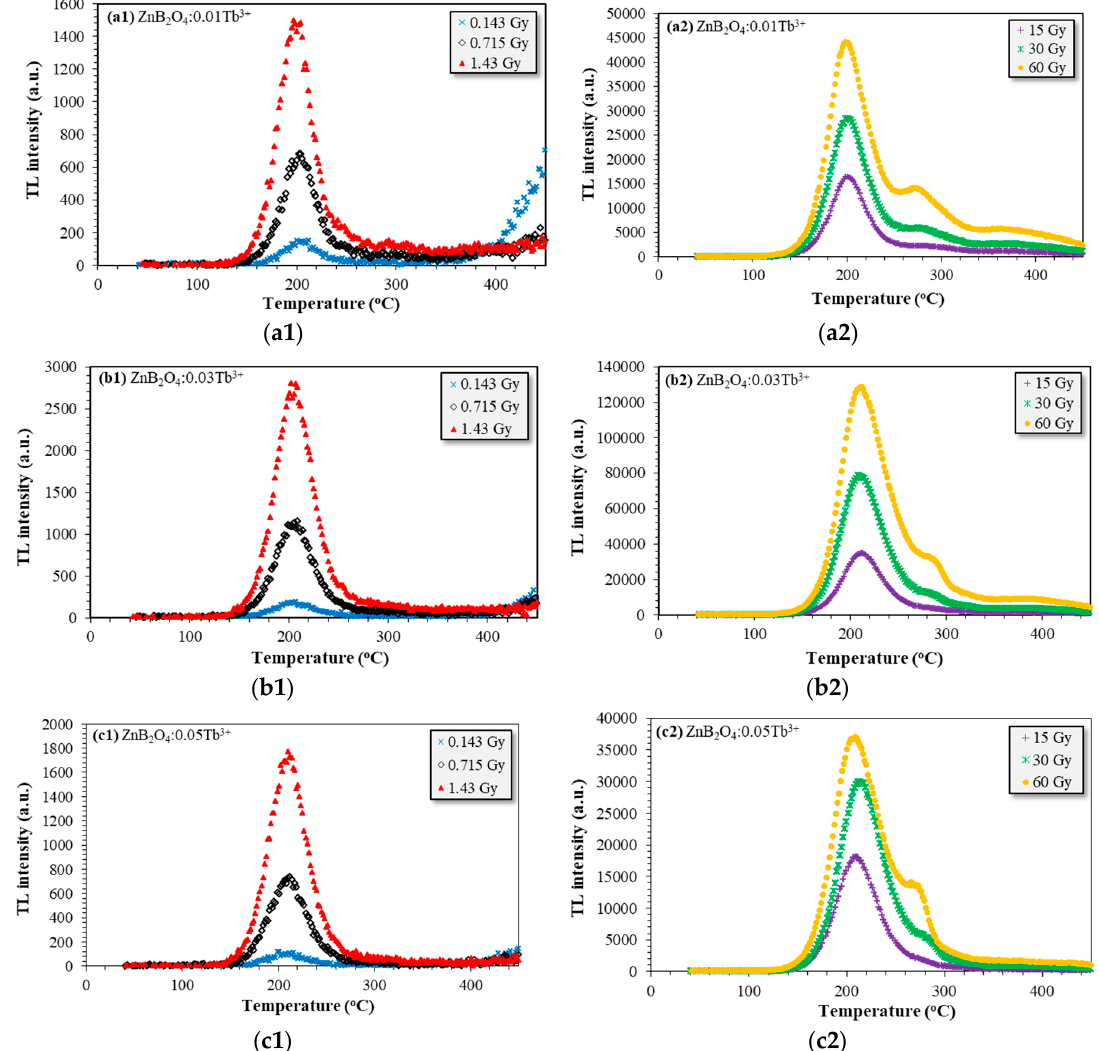
Figure 3. Experimental TL glow curves of ZnB 2 O 4 :xTb 3 + ( a1–a2 ) x = 0.01, ( b1–b2 ) x = 0.03 and ( c1–c2 ) x = 0.05.